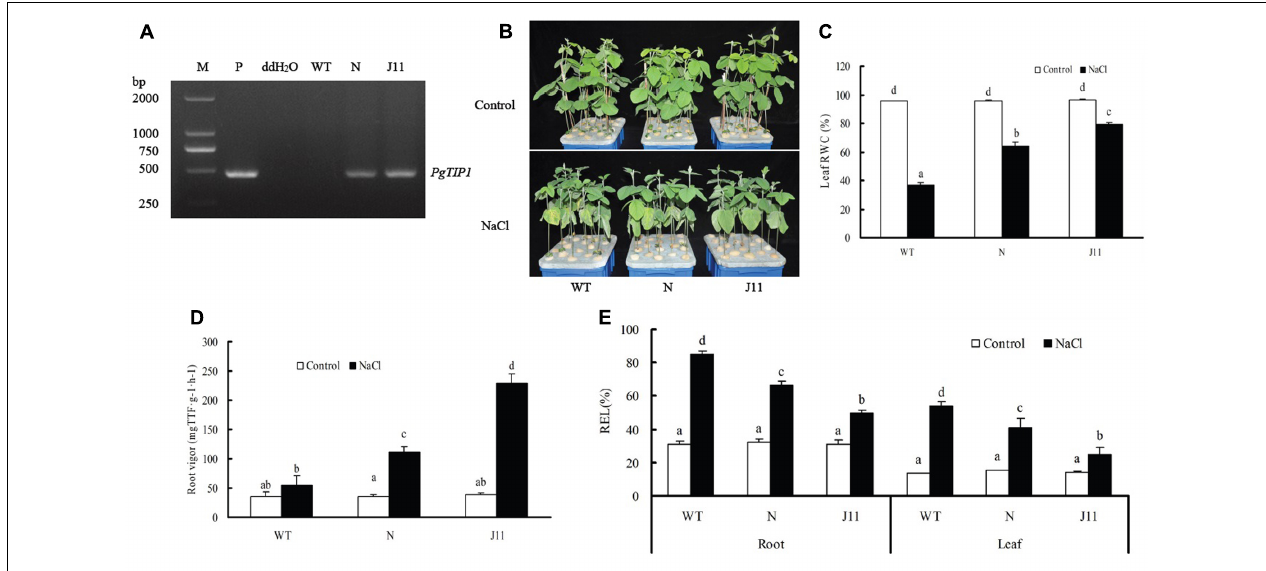
FIGURE 4 | Growth phenotype and physiological responses of WT and PgTIP1- transgenic soybean lines under NaCl treatment. (A) The seedlings (T 3 generation) of PgTIP1 transgenic soybean lines N and J11, and WT (cv. Nannong 8831) were screened by PCR. The PCR-verified seeds and WT were surface-sterilized, soaked, germinated, and planted in plastic pots containing quartz sand, fertigated with 1 / 2 Hoagland solution, and maintained in a greenhouse with a temperature ranging from 18 ± 2 ◦ C to 25 ± 2 ◦ C and a 14 h/10 h (day/night) photoperiod. At the time of the 1st trifoliate leaf expansion, the plants were subjected to salt stress by fertigating with 1 / 2 Hoagland solution plus 150 mM NaCl, or 1 / 2 Hoagland solution devoid of NaCl as the control treatment. The Hoagland solution treatments were replaced every 2 days. After 7 days treatment, (B) the growth phenotype was photographed, and measured (C) RWC in the 1st pair of unifoliate leaves, (D) root vigor, and (E) REL in roots and the 1st pair of unifoliate leaves. Each bar represents the mean and SD of three replicates, means in bars followed by different letters show significant difference ( P < 0.05) between the parameters of WT and PgTIP1- transgenic